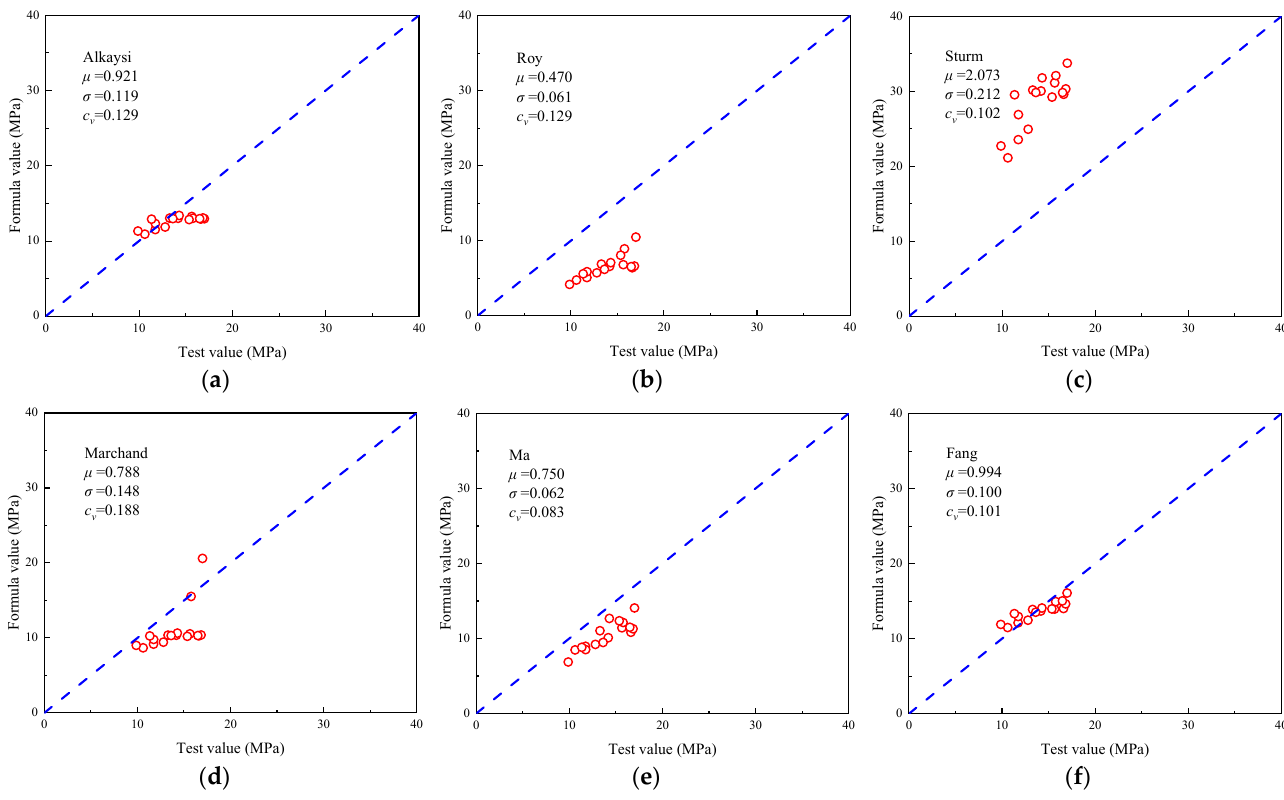
Figure 6. Comparison of bond strength between test values and formula values: ( a ) Alkaysi; ( b ) Roy; ( c ) Sturm; ( d ) Marchand; ( e ) Ma; ( f ) Fang. Through the above comparison results, the empirical equation of bond strength in